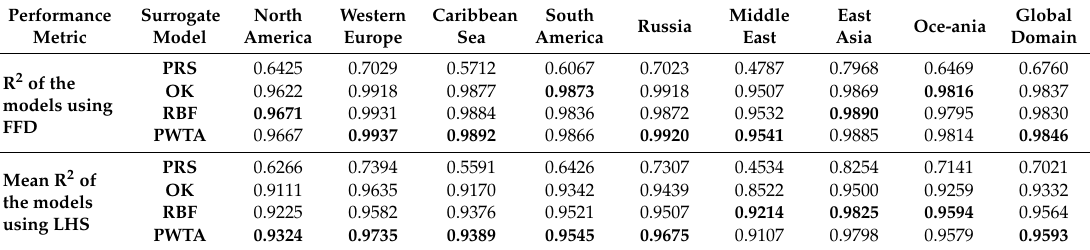
Table 3. Comparisons of R 2 for di ff erent surrogates using LHS and FFD,